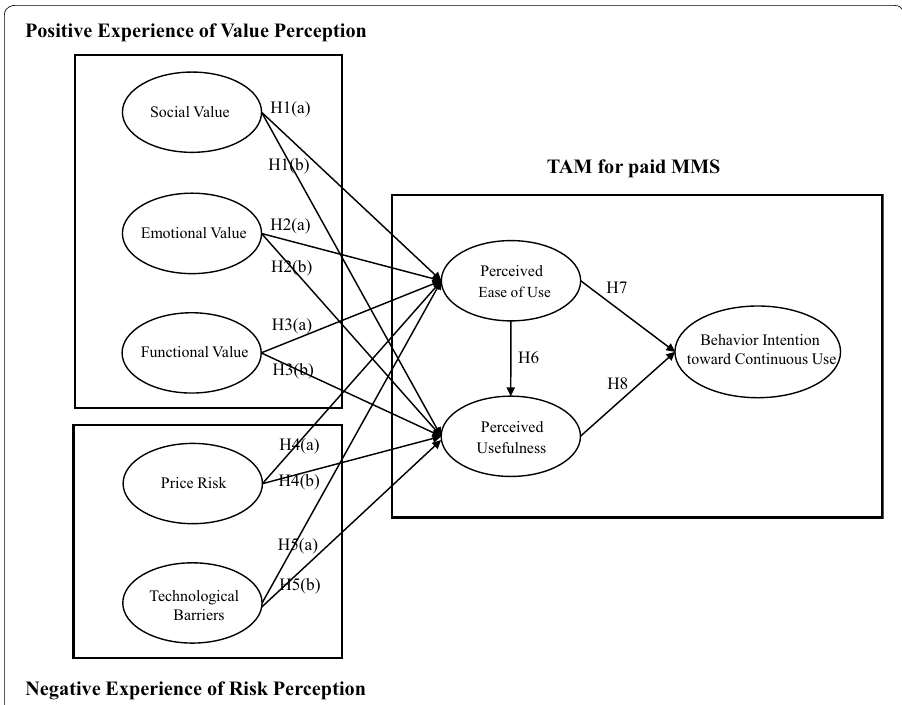
Fig. 2 Proposed research